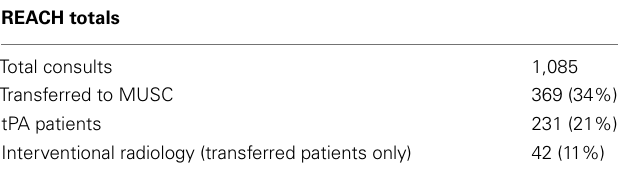
Table 2 | REACH overall data.